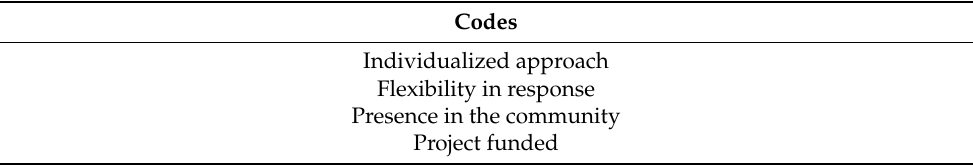
Table 3. Codes within a theme. Characteristics of